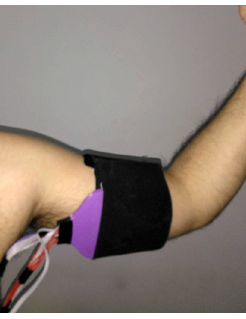
Figure 11: The stimulation interface worn in the biceps of a user.